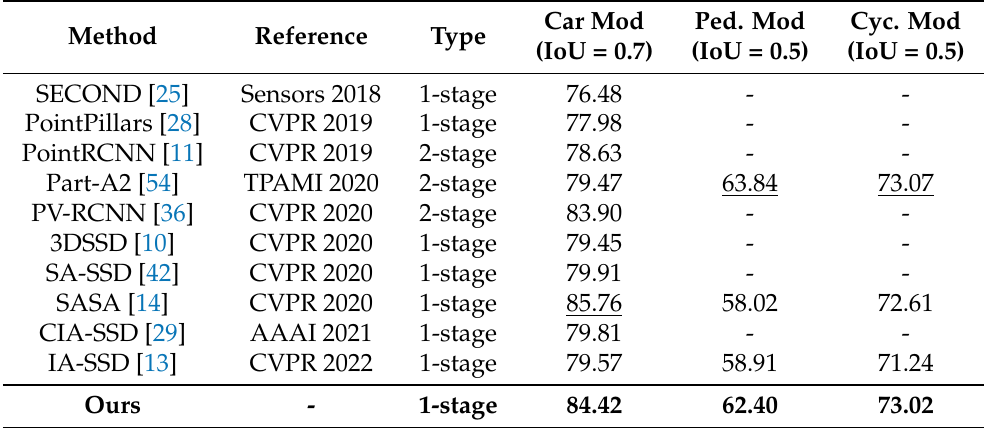
Table 2. Quantitative comparison of different approaches on the validation split of the KITTI dataset. The mean average precision is measured with 11 recall positions AP 11 . The results of our SGSSD are shown in bold, and the best results are underlined.